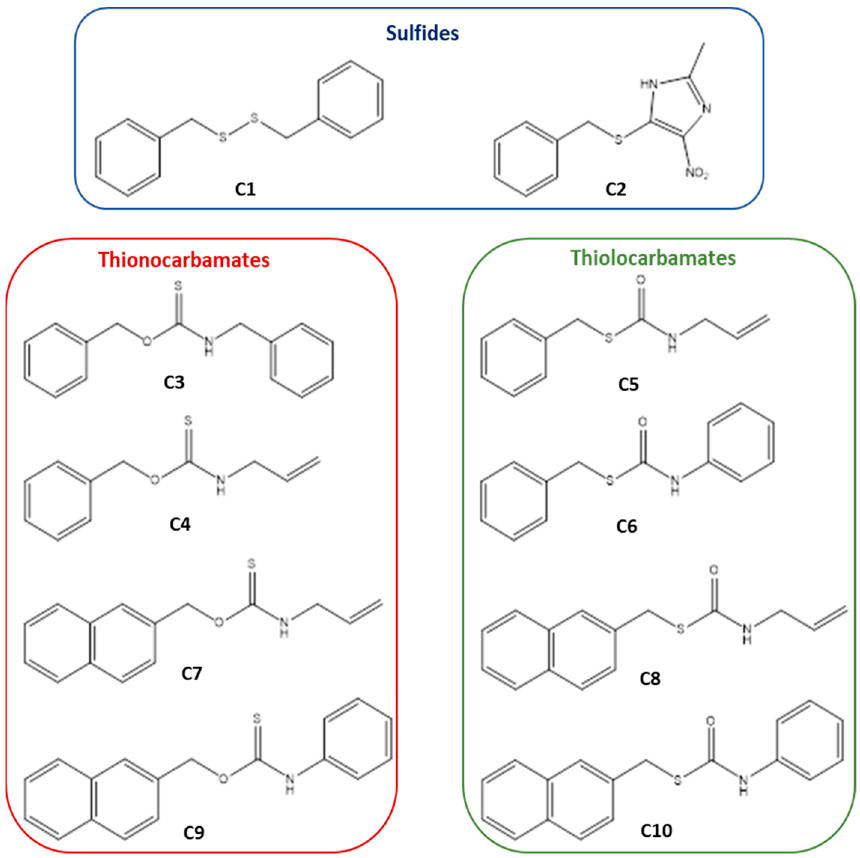
Figure 2. The structures of the tested compounds.